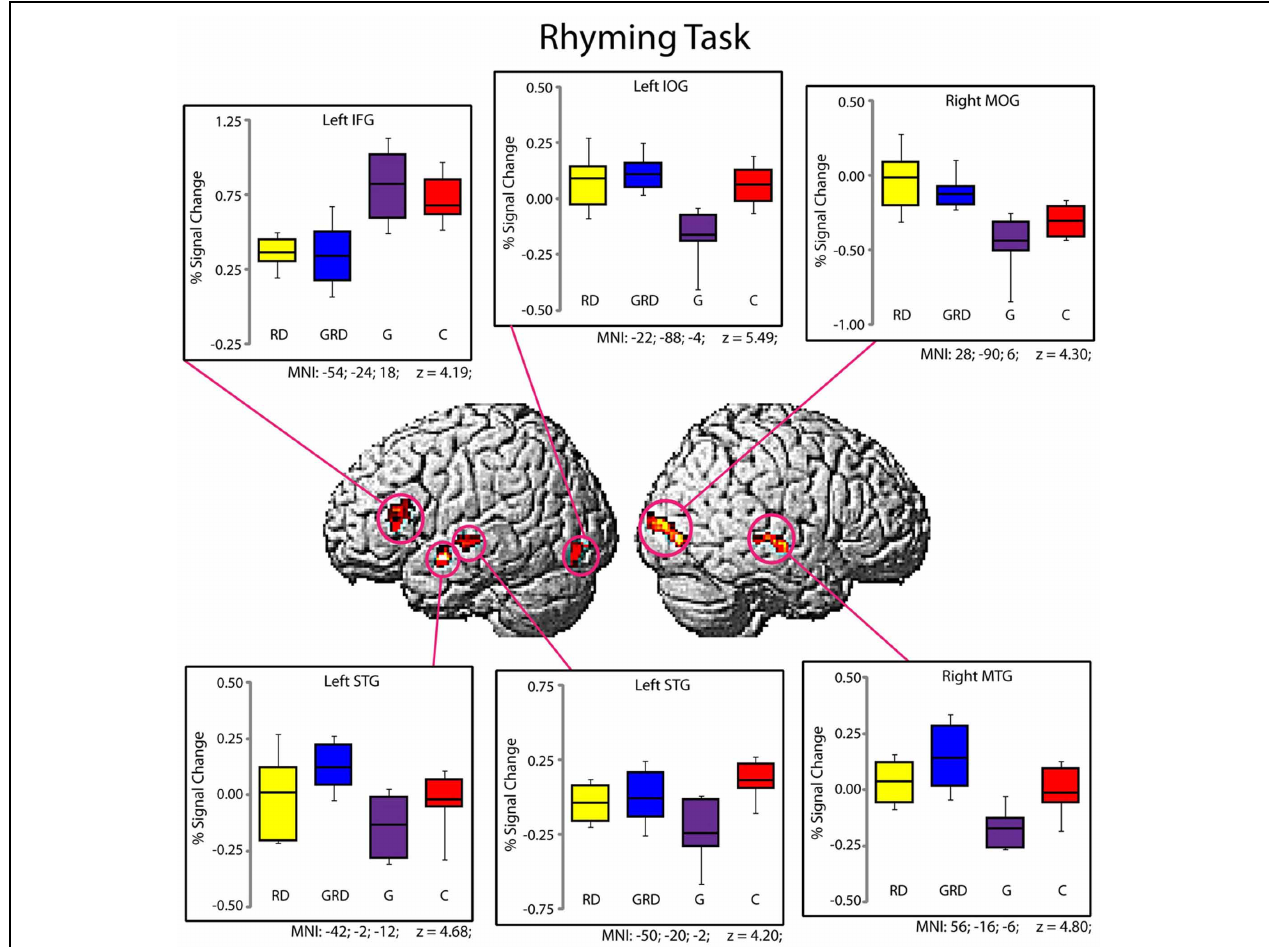
blue, G: purple, C: red). Horizontal lines within the boxplots represent the average percent signal change for W and NW tasks. First and third quartiles are defined by the box edges, and whiskers define the10th and 90th percentiles. MNI co-ordinates of the peak location within the clusters are presented below each corresponding boxplot and in Table 4 . Patterns of activation were generally similar for RD and GRD